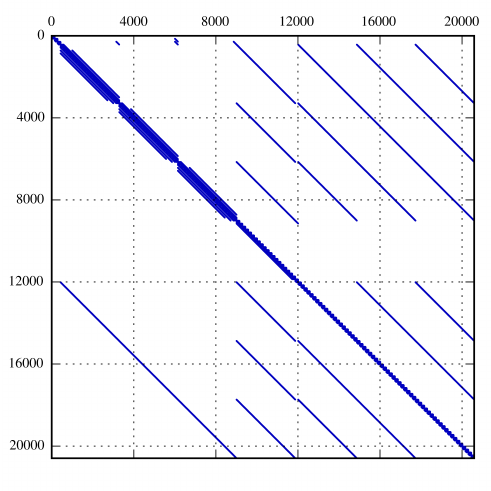
Figure 5. The sparsity pattern of Equation